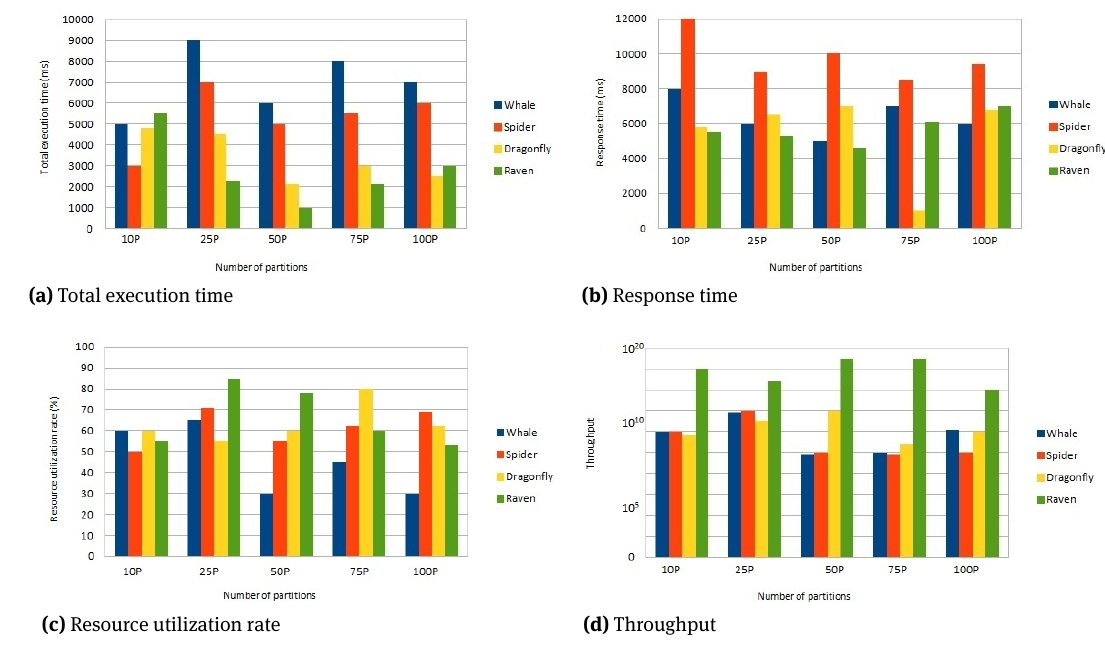
Figure 6: Performance under